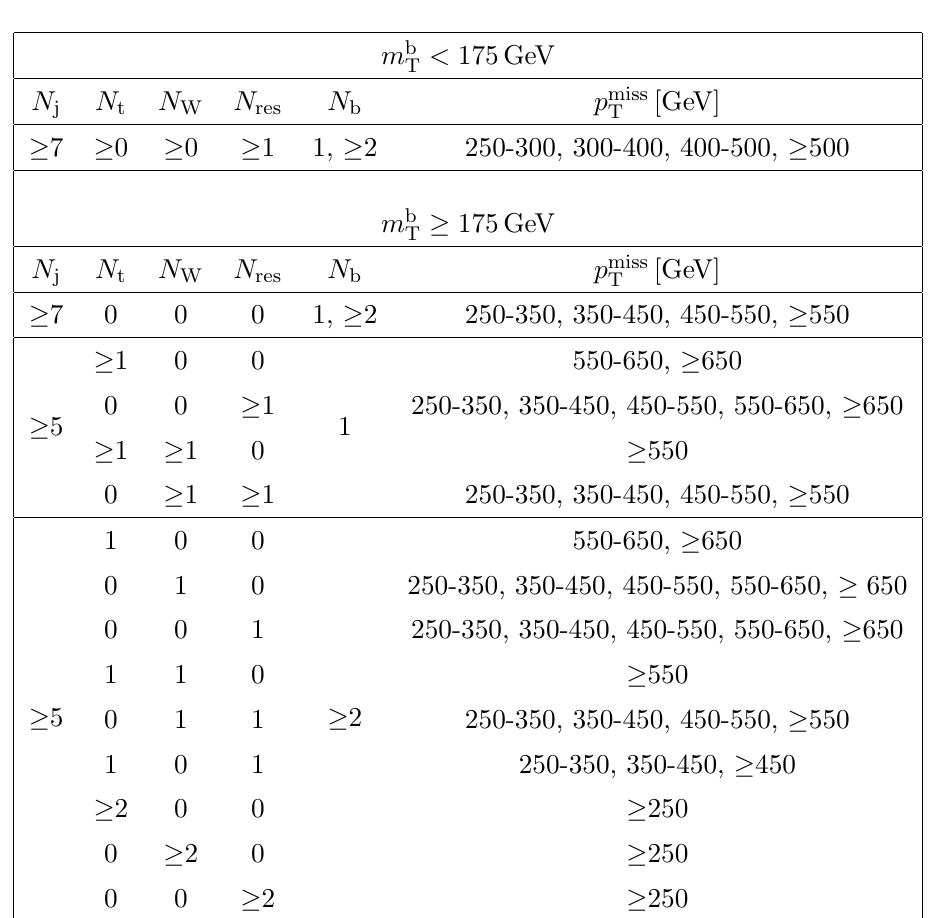
Table 1 . Summary of the 51 non-overlapping search regions that mainly target high (cid:1) m signal. The high (cid:1) m baseline selection is N j (cid:21) 5, p miss